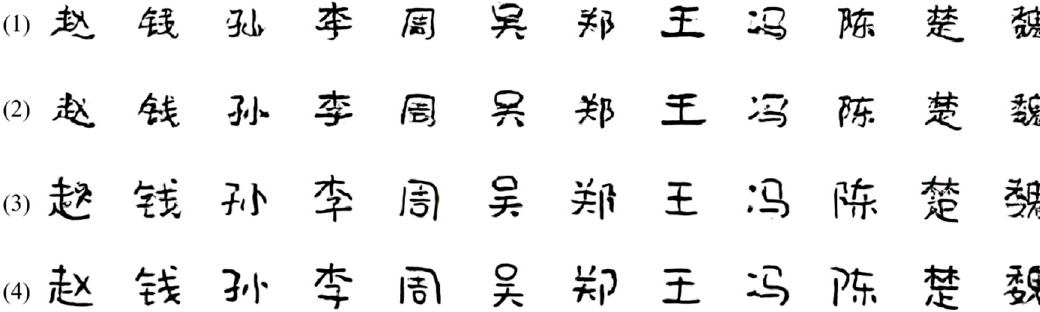
Figure 11. The comparison results of fonts generated by our models. The images of the first and second rows are the characters of Font 9, and the third and fourth rows are of Font 6. The models used to generate the images of the first to fourth rows are EG-GAN 1,2 , EG-GAN 1 , EG-GAN 2 and EG-GAN, respectively.